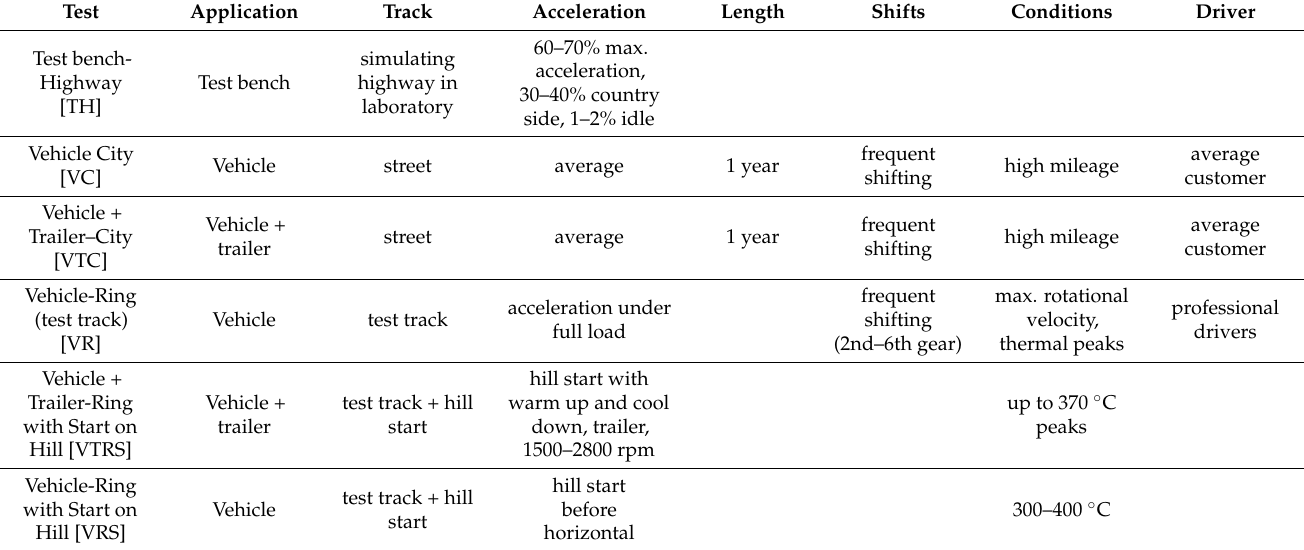
Table 2. Automotive industry tests ensuring dry clutch facing quality during its